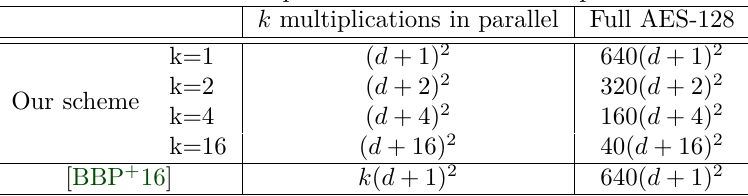
Table 1: Estimated computational cost 1 of AES implementations k multiplications in parallel Full